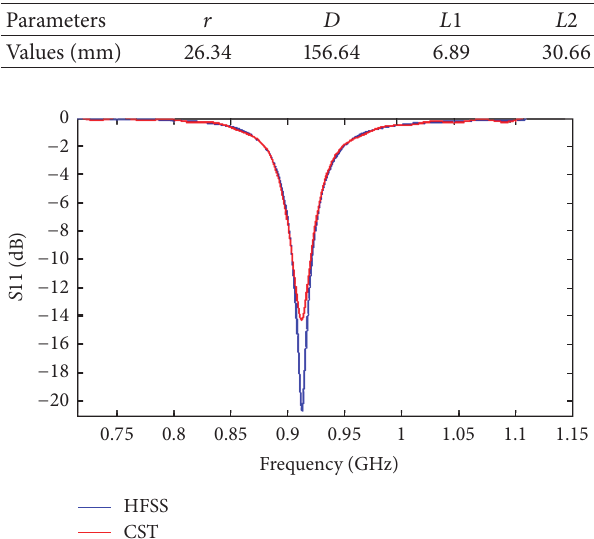
Figure 7: Return loss 𝑆11 of the 3D spherical antenna (Table 2).